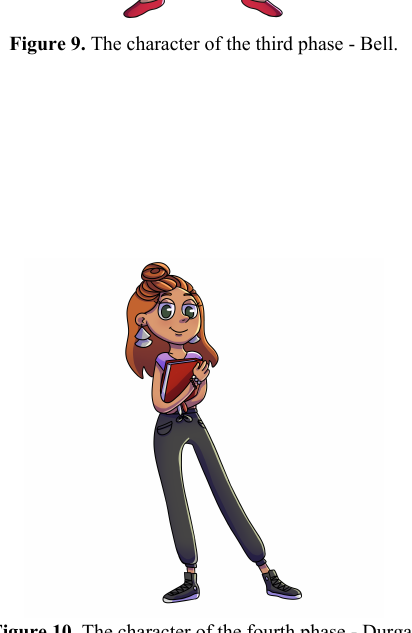
Figure 12. Age group - Test